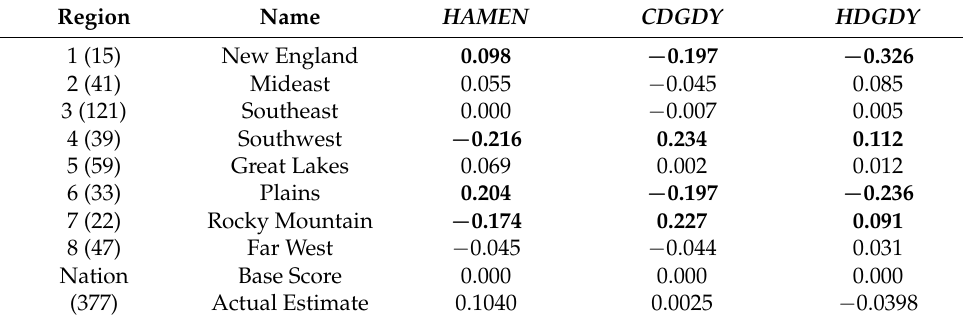
Table 6. Pooled Standard Scores for the Four Population